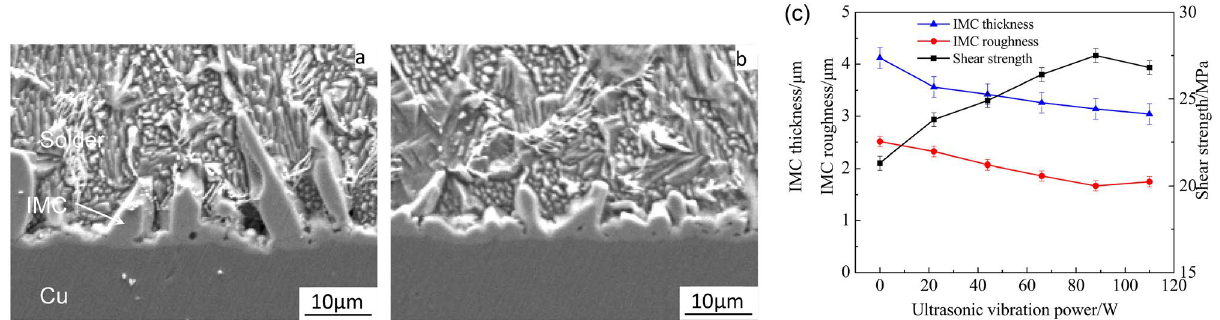
Figure 4. Effects of ultrasonic vibration power on ultrasonic-assisted Sn2.5Ag0.7Cu0.1RE0.05Ni/Cu solder joints: ( a ) 0 W, ( b ) 88 W, ( c ) IMC thickness, IMC roughness and shear strength of the solder joints.